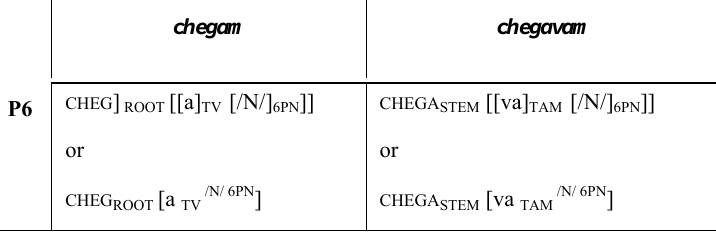
Table 1.1 – Morphophonological structure of P6 (cf. canonical phonetic